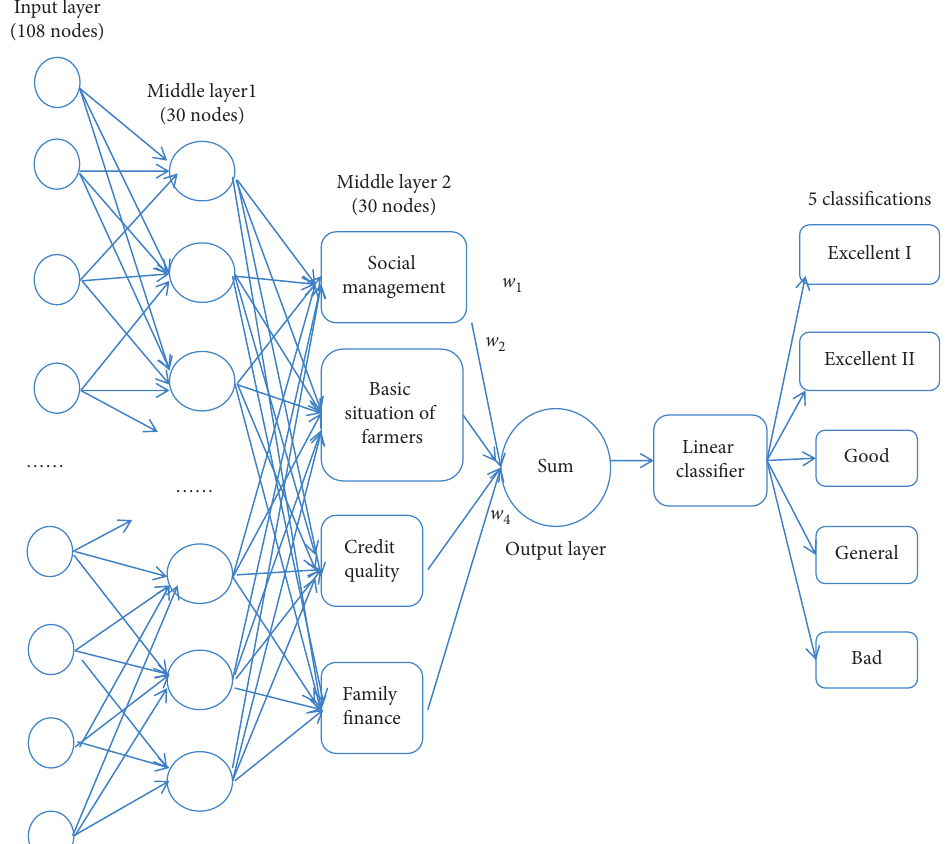
Figure 3: A multilayer one-way network of farmer credit rating with 4 inputs and 5 classifications ( A County in Guangdong